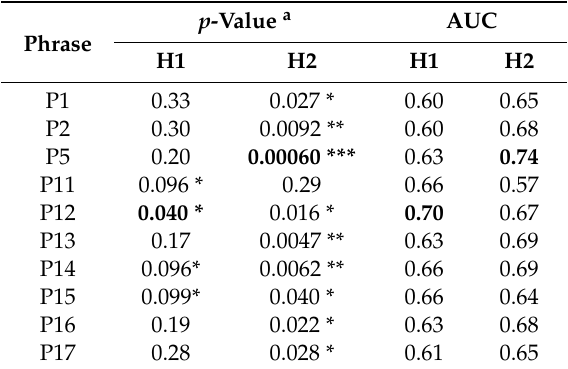
Table 4. A summary of classification performance between the no depression and depression groups through arousal level voice index.